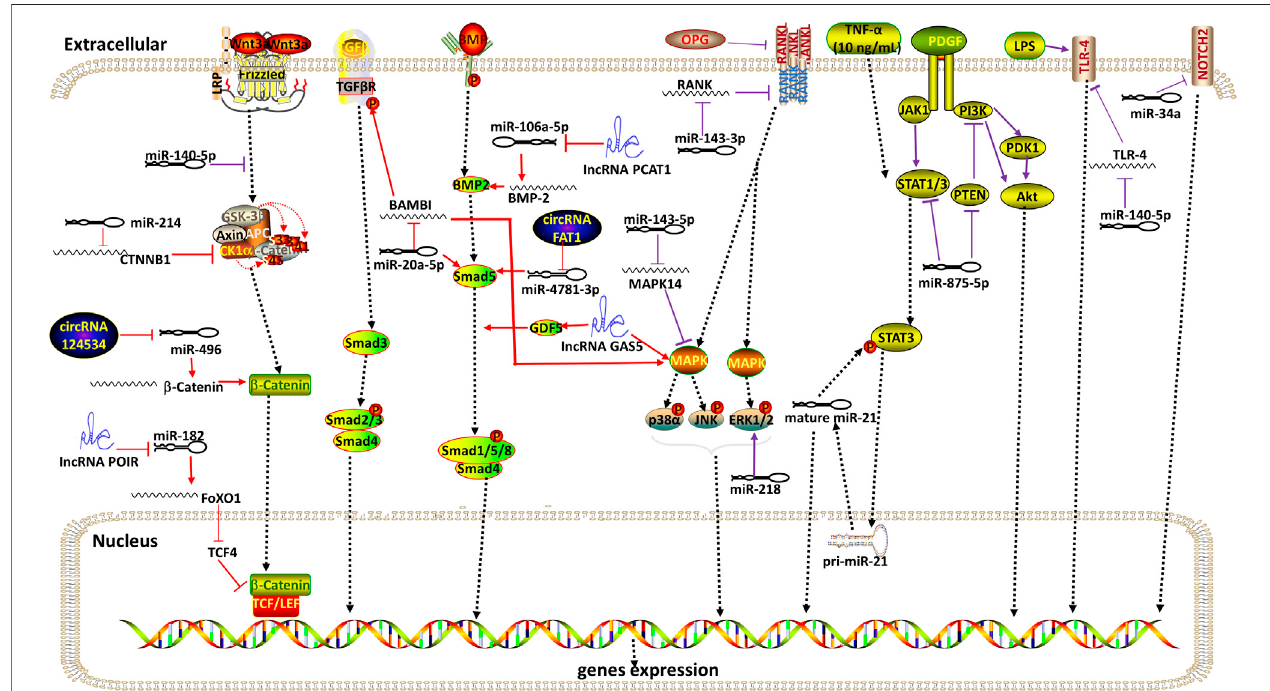
FIGURE3| OverviewofsignalingpathwaysinvolvedbyncRNAsduringthedifferentiationofDMSCs.Redindicatessignalingpathwaysassociatedwithosteogenic differentiation. Purple indicates signaling pathways associated with odontogenic differentiation. Arrow indicates promotion and T indicates inhibition. Collectively, ncRNAs related to Wnt/ β -catenin signaling pathway are miR-140-5p, miR-214, circRNA124534 and lncRNA POIR. MiR-20a-5p is involved in TGF- β , BMP and MAPK signaling pathway. NcRNAs associated with the BMP signaling pathway are lncPCAT1 and circRNA FAT1. LncRNA GAS5 isinvolved in BMP and MAPK signaling pathway. MiR-143-3p inhibits OPG-RANKL signaling pathway. NcRNAs related to the MAPK pathway are miR-143-5p, miR-218. MiR-875-5P is related to PDGF signalingpathway.ThereisareciprocalpositivefeedbackloopbetweenmiR-21andSTAT3atlowconcentrationsofTNF- α (1 – 10 ng/ml).MiR-140-5pinhibitstheTLR-4 pathway under LPS stimulation. MiR-34a inhibits Notch signaling